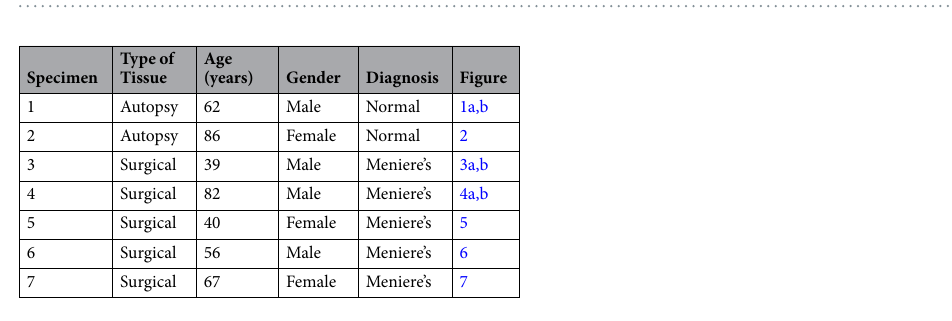
Figure 8. Diagram to represent the BLB in ( a ) normal capillary and ( b ) Meniere’s disease capillary. In Meniere’s disease, there are excessive vesicular formation (ves), abluminally concentrated, with degenerative changes noted early on in the endothelial cell (vec). The perivascular basement membrane (pbm) is thickened and edematous. Tight junctions (tj) are relatively preserved. Pericytes (p) exhibit vacuolization, and pericyte process detachment.